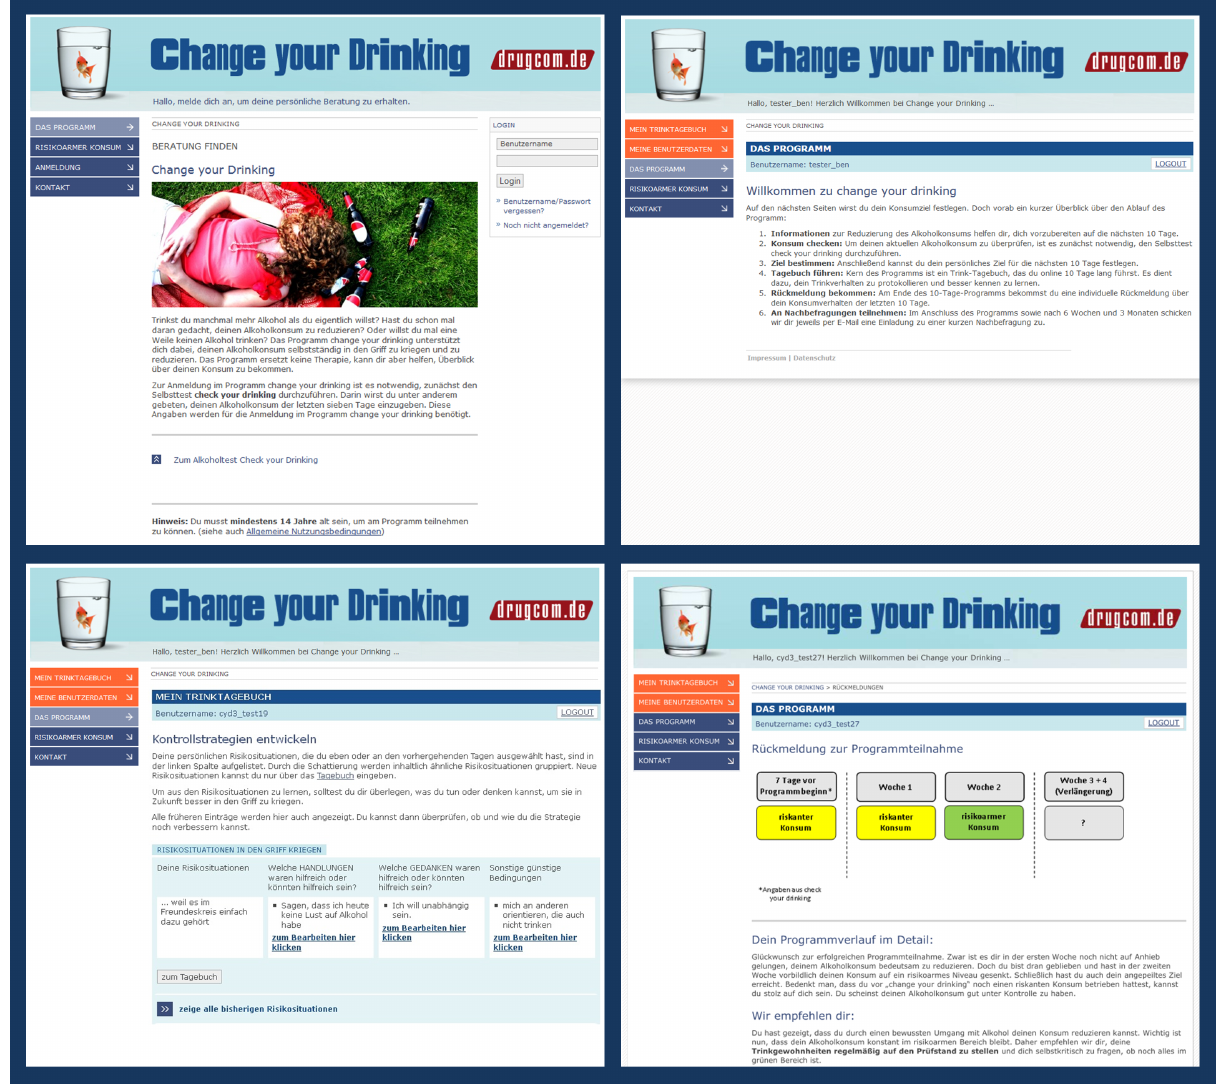
Figure 1. Screenshots of the Change Your Drinking intervention (version